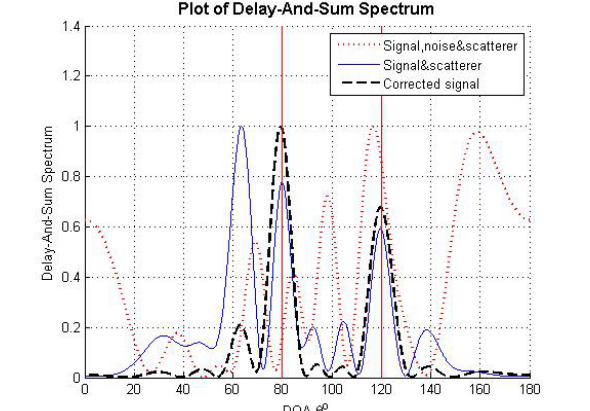
Figure 8: DOA spectrum for case